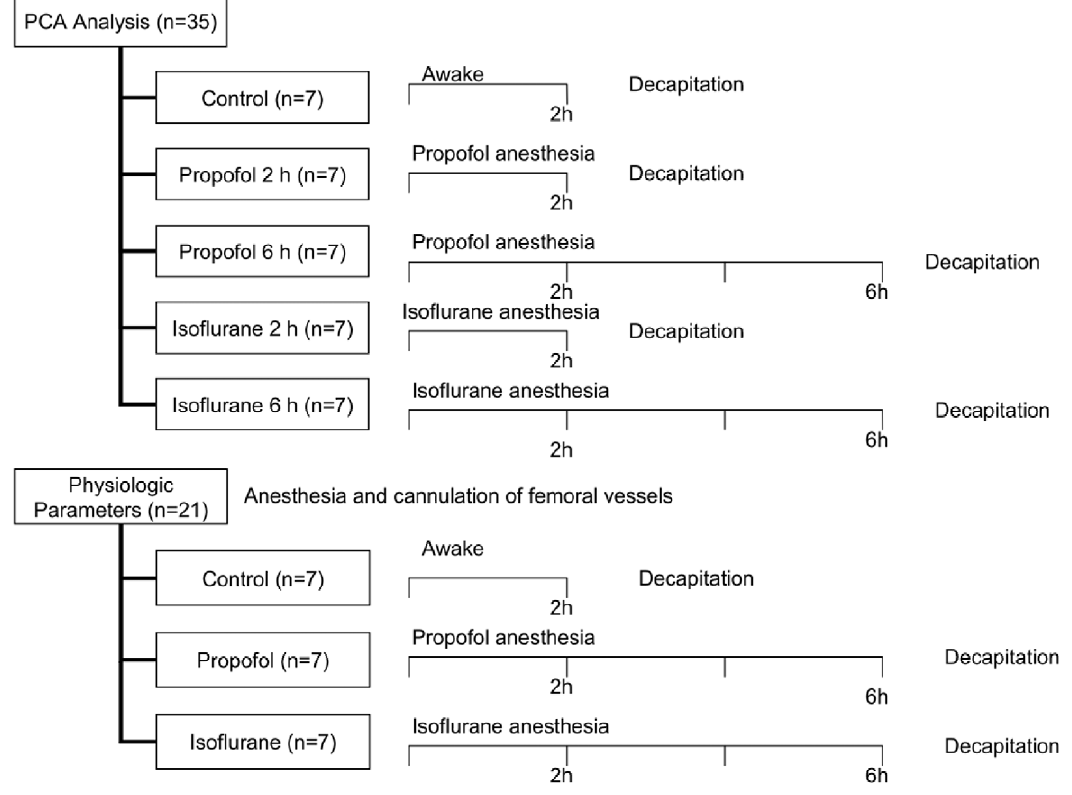
Figure 1. Flow chart of the experimental protocol.